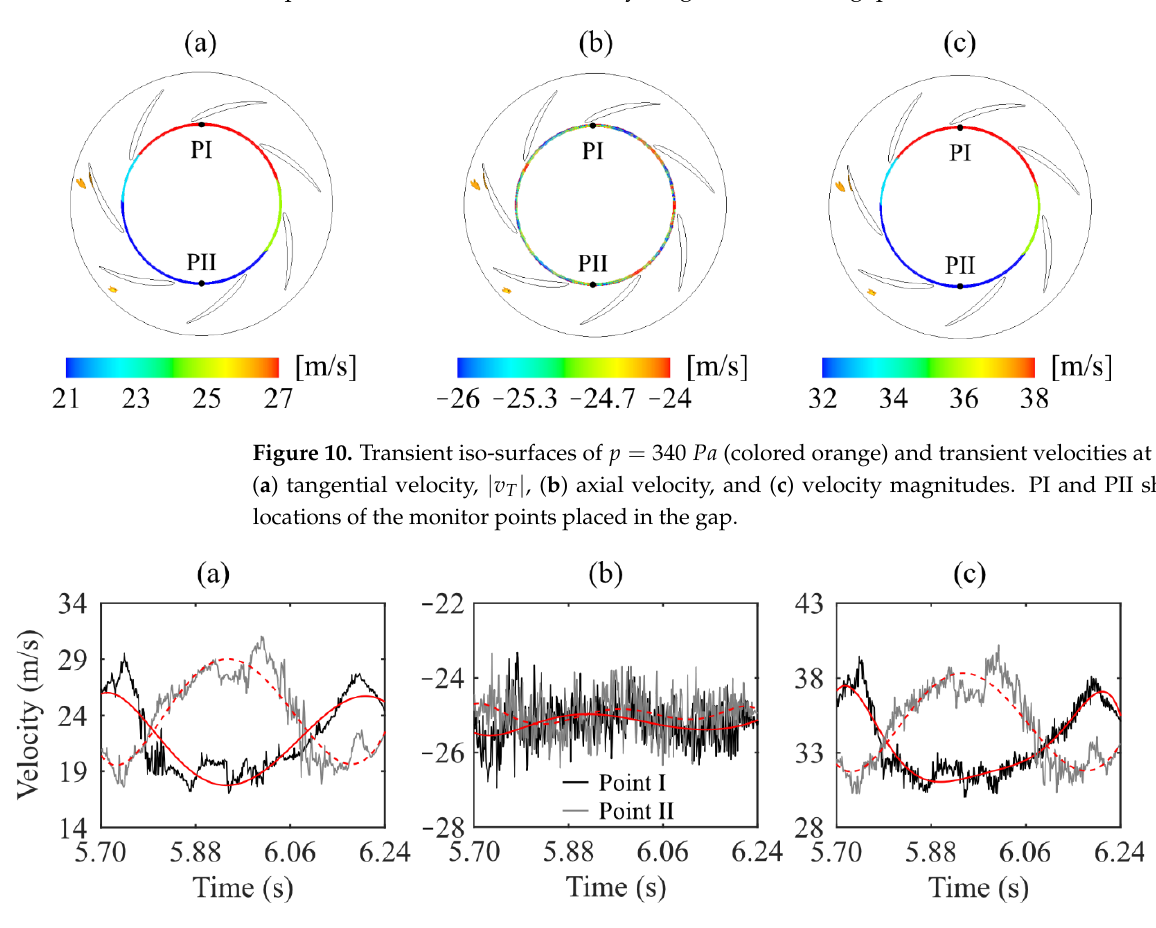
Figure 11. The time history of the variables at the gap: of ( a ) the tangential velocity, |𝒗 𝑇 | , ( b ) the axial velocity, and ( c ) the velocity magnitudes. Black and gray lines: the instantaneous velocity; red lines: the fitted curves based on the Gaussian functions, the solid red line for Point I and the dashed red line for Point II.